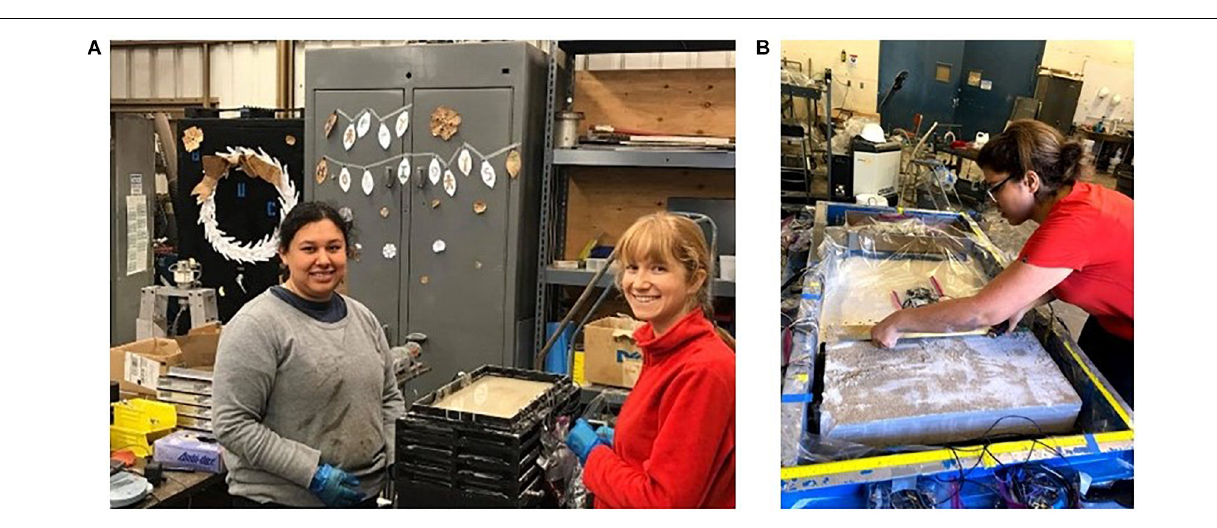
FIGURE 11 | Bio-mediation of sand models for centrifuge testing: (A) component level model for testing on the 1-m radius centrifuge, and (B) system level model for testing on the 9-m radius